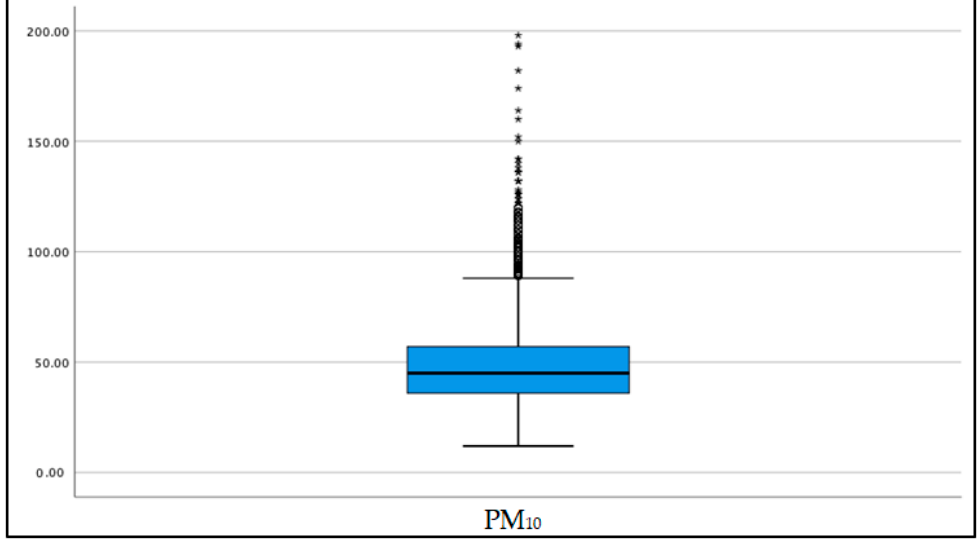
Figure 3. Box plot for PM 10 concentration.